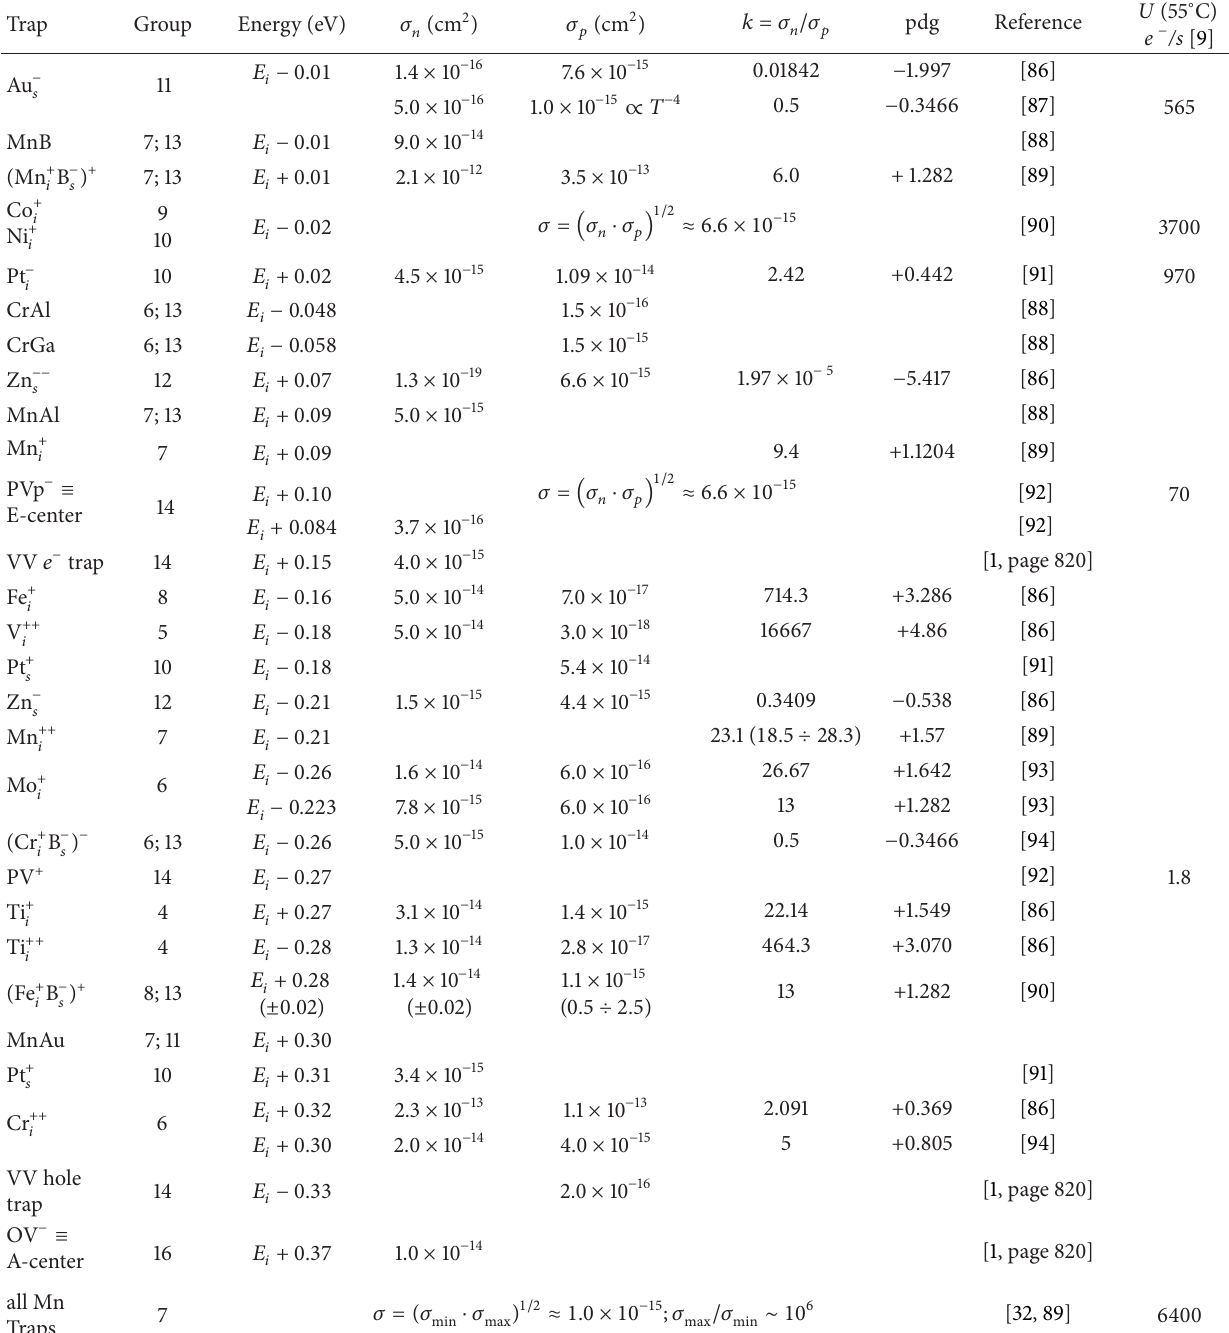
Table 2: Some known values of the traps energy levels, of both capture cross-sections of free electrons and holes, respectively, in silicon, as well as of their polarization degree (pdg), implicitly.